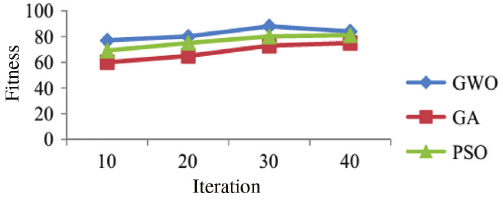
Figure 10: Fitness Comparison.